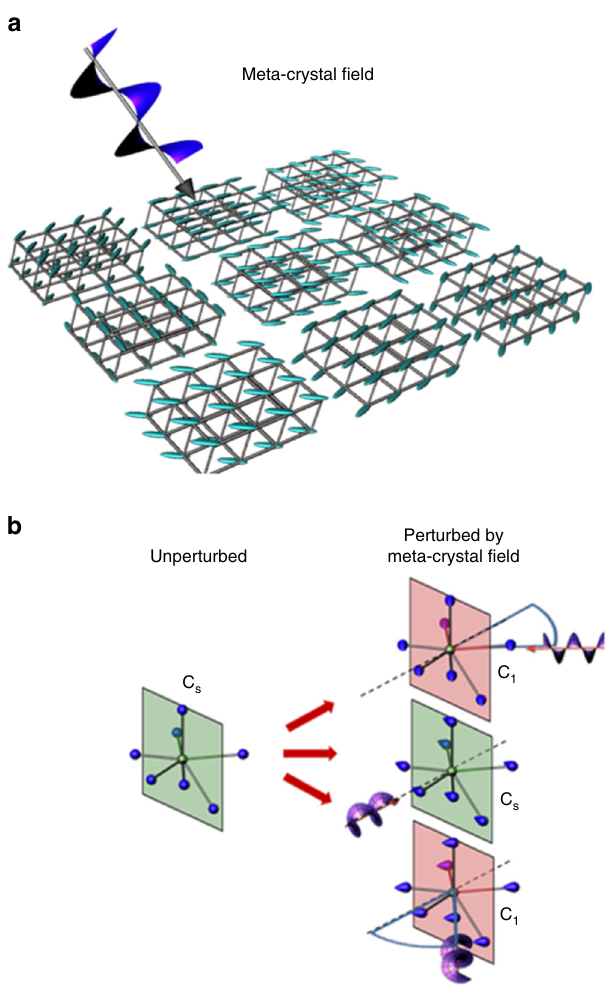
Fig. 1 Meta-crystal fi elds and symmetry reduction. a The graphic illustrates the precession of the induced polarisation (represented by the ellipsoids) over an extended length scale. The incident CPL is shown. For simplicity the effect is illustrated with an idealised periodic lattice, the real fi lms are structurally disordered. b The symmetry-reducing effects of the meta-crystal fi eld illustrated for a monoclinic-like co-ordination environment (green and blue spheres/ellipsoids are Eu 3 + and O 2 − ions, respectively). A range of propagation directions relative to the mirror plane normal (dotted line) are shown. The red and green areas represent mirror planes, which have been lifted or retained, respectively, after the application of the meta-crystal fi eld perturbation. The point group of the perturbed lattice is given beside the